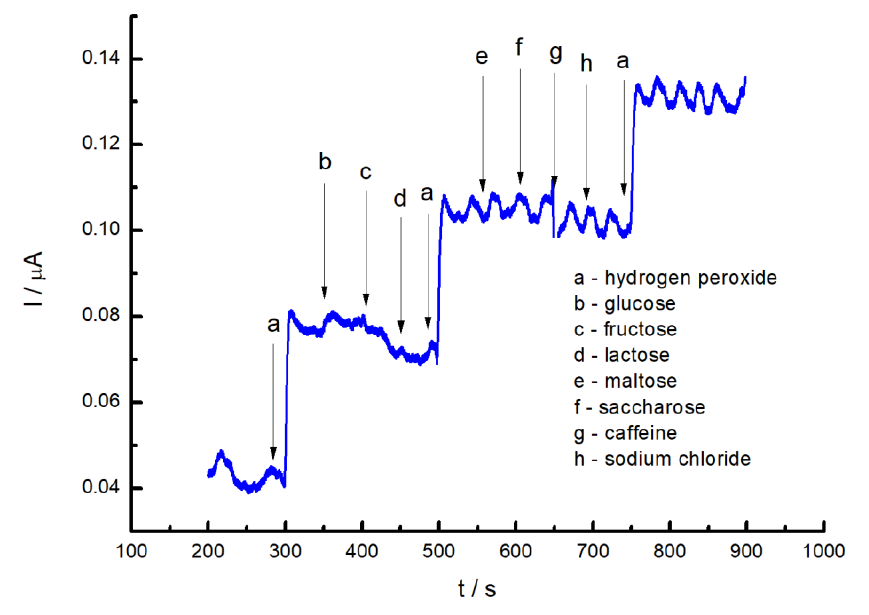
Figure 7. Chronoamperometric responses recorded at the GC/MWCNTs/ Pz3 sensor upon addition of 100 µ M H 2 O 2 and selected interferents. The applied potential was +0.6 V. The supporting electrolyte was phosphate buffer (pH 7.4).